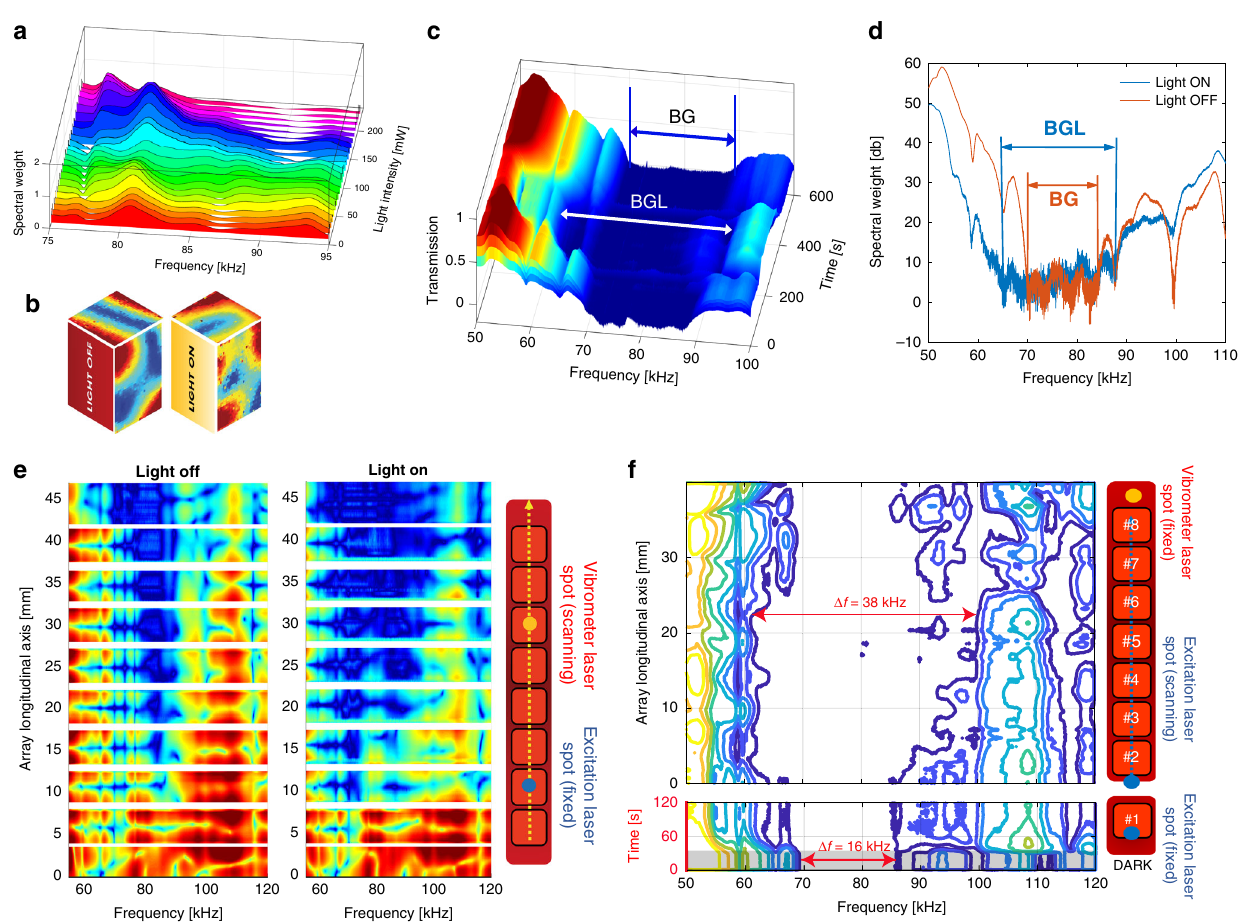
Fig. 2 Photo-induced tunability of the LRMM frequency response. a Spectral response of pillar #1 in the range 75 – 95 kHz under illumination at increasing intensity. Measurements are performed at the center of the top surface of the pillar. b 3D representation of the displacement distribution over pillar #1 surface (top and lateral) produced by a monochromatic elastic wave excitation at 98 kHz, without and with illumination at 200 mW laser power. c Temporal evolution of the LRMM transmission spectrum under laser illumination. At t = 100 s, the laser beam is switched ON and selectively directed on pillar #1 only. Then, at t = 360 s the laser is switched OFF. The normalized amplitude of the out-of-plane elastic wave oscillations is collected as a function of time, at the waveguide edge opposite to the piezo source. A light-induced band gap (BGL) can be observed as a result of a widening and a down-shift of the lower edge of the original band gap (BG). The change of the spectral response can be appreciated almost instantaneously, but a time interval of about 100 s is required to reach a steady state. d Transmission spectrum of the LRMM upon a broadband excitation without illumination (red curve) and during the illumination of the fi rst pillar, once a steady state is reached (blue curve). e Spatially resolved spectral response of the LRMM without illumination (left panel) and under illumination of pillar #2 only (right panel) obtained by SLDV along the longitudinal x -axis of the sample. f Contour plot of the LRMM transmission spectrum measured at an output point at the end of the waveguide during a scan of the excitation laser from pillar #1 to pillar #8. During the fi rst 30 s, spectra are collected without illumination, for reference purposes, then pillar #1 is illuminated while keeping constant the position of the excitation laser for t = 100 s. Next, the excitation laser is slowly moved so that each pillar is sequentially illuminated. The frequency band of the BG broadens from 16 kHz without illumination to 38 kHz corresponding to the illumination on pillar #6. Colors from blue to red indicate an increasing amplitude of the measured out-of-plane